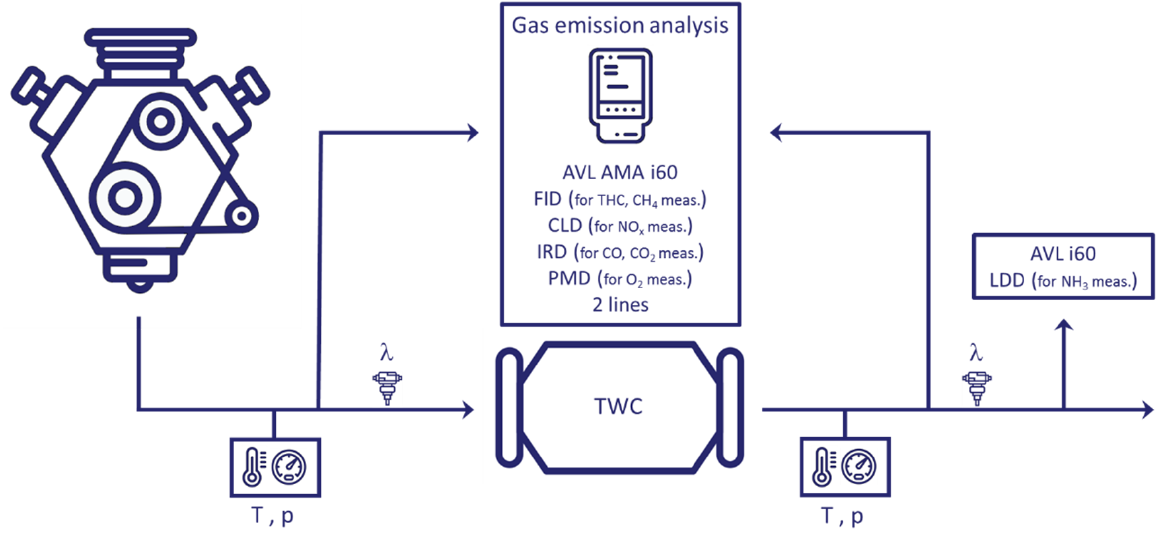
Figure 1. Engine test bench experimental layout.